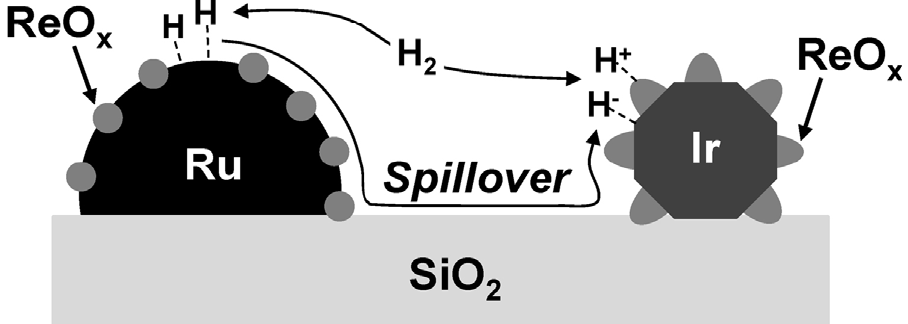
Figure 10. The hydrogen spillover on the Ru-Ir-ReO x catalysts. Reproduced from [80] with permission from Elsevier.